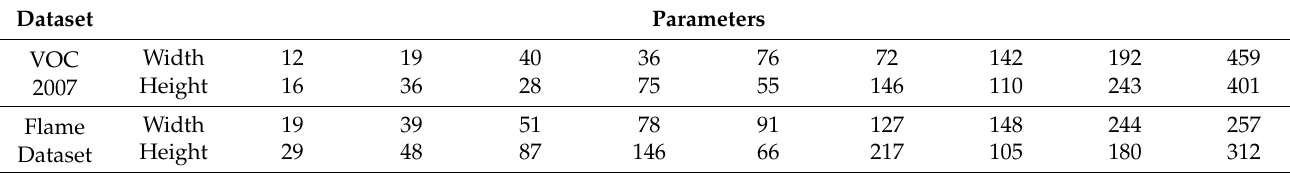
Table 4. Width and height of the anchor frame.